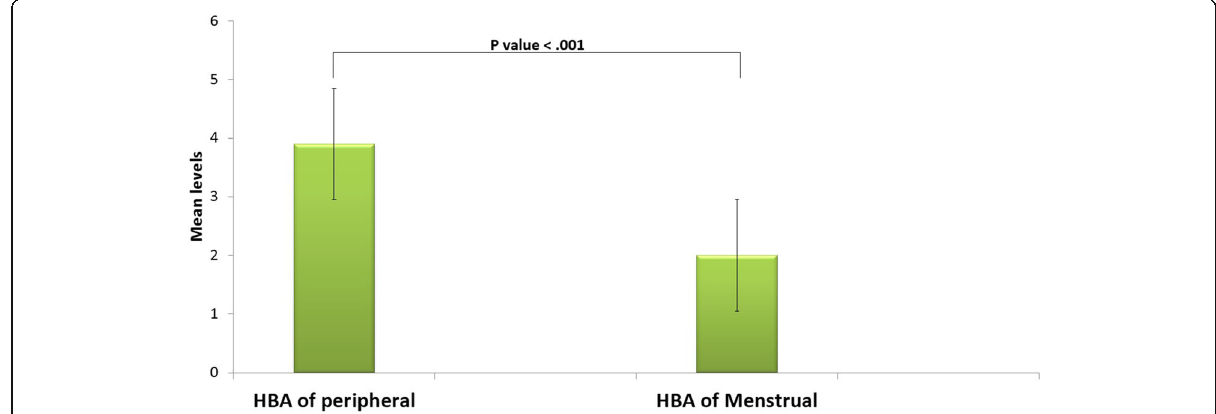
Fig. 1 HBA in peripheral (male and female participants) and menstrual blood